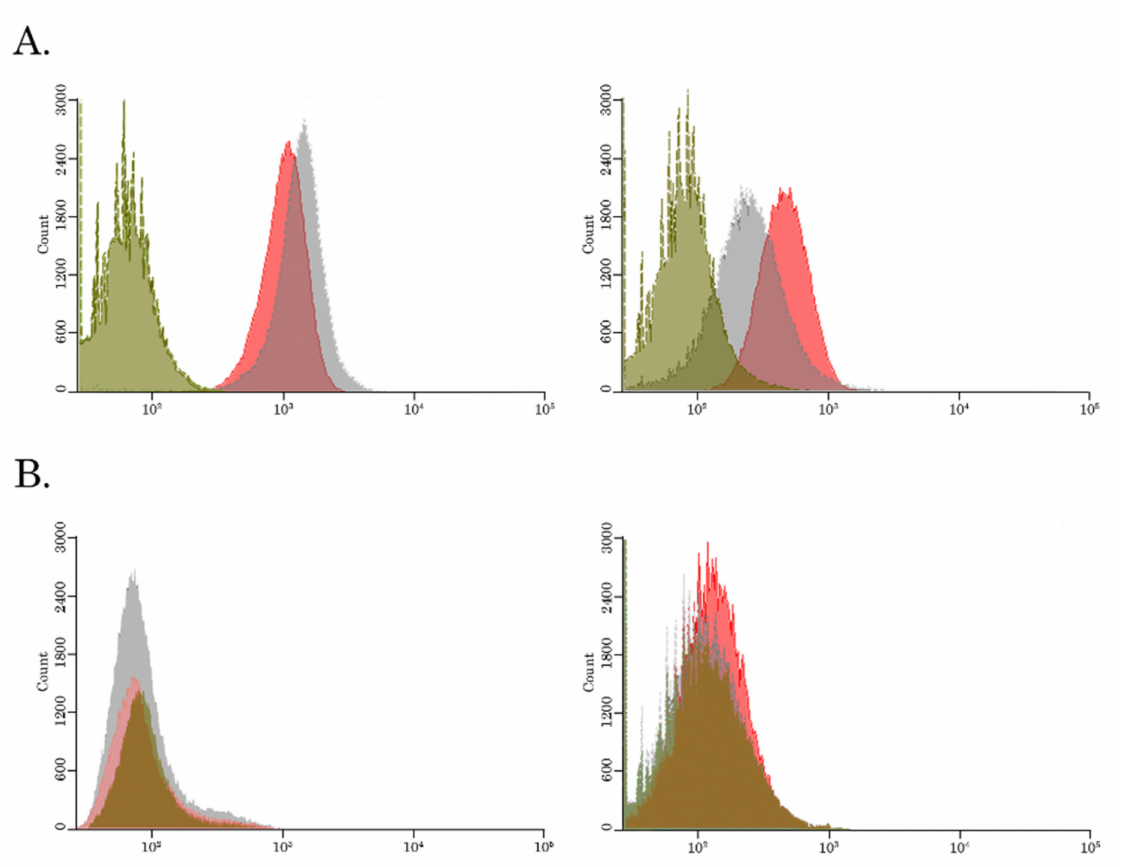
Figure 3. BGJ 398 increases the intracellular accumulation of Dox ( A ) and Flutax-2 ( B ) in Tx-R HCC 1806 breast cancer cells. ( A ) The intracellular accumulation of Dox in drug-sensitive parental HCC 1806 cells (left) and Tx-R HCC 1806 cells (right). The cells were treated with DMSO (green), Dox (40 µ M) alone (gray) or in combination with BGJ 398 (20 µ M) (red). ( B ) The intracellular accumulation of Alexa-488 labeled PTX (Flutax-2) in drug-sensitive parental HCC 1806 cells (left) and Tx-R HCC 1806 cells (right). The cells were treated with DMSO (green), Flutax-2 (3 µ M) alone (gray) or in combination with BGJ 398 (20 µ M) (red). The fluorescence intensity was analyzed by FACs. Representative histograms of at least 3 independent experiments are